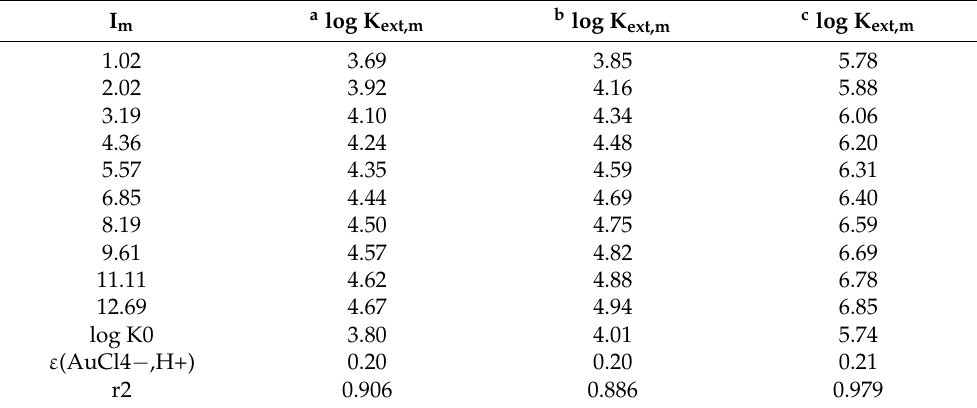
Table 4. Results of plotting of log K ext,m versus I m